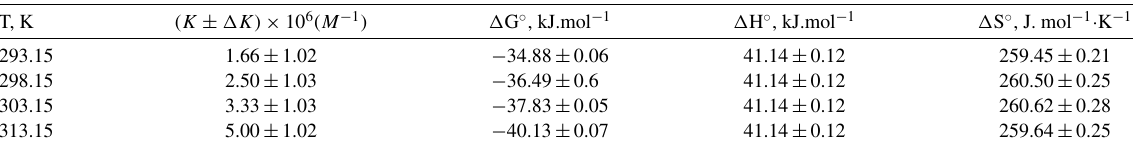
Calculated thermodynamic parameters for binding of Zn(tmtppa) to Poly (G-C) in 5mM phosphate buffer, pH 7.2, at 25 ◦ C